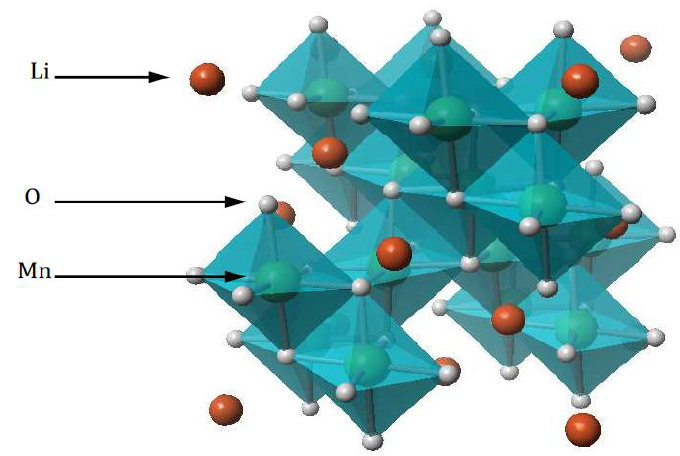
Figure 6. Structure of spinel LiMn 2 O 4 . Reproduced with permission [71]. Copyright 2013, Elsevier.